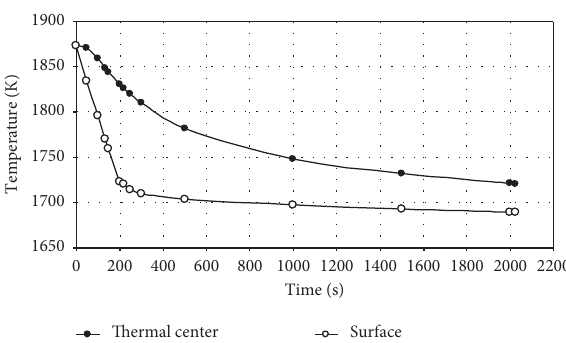
Figure 6: Temperature distribution in the steel casting (Figure 1) during the period from pouring to full